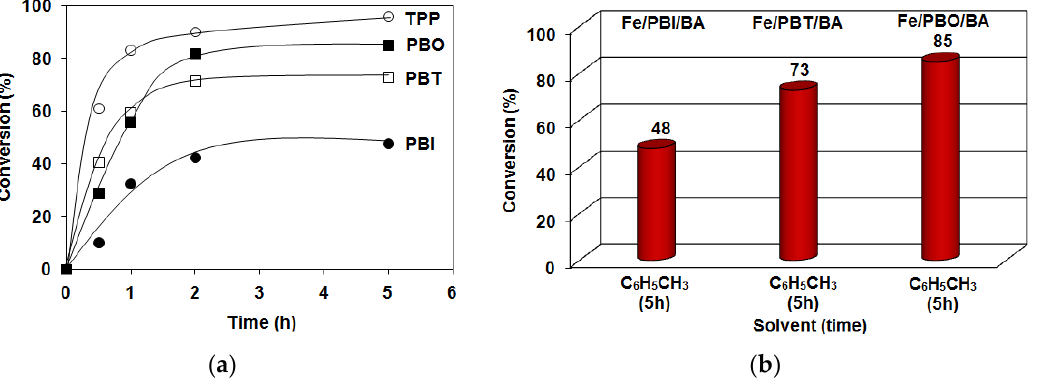
Figure 1. Comparison of the efficiency for the oxidation of cyclohexanone employing [Fe II (PBO) 2 (CF 3 SO 3 ) 2 ] ( 1 ), [Fe II (PBT) 2 (CF 3 SO 3 ) 2 ] ( 2 ), and [Fe II (PBI) 3 ](CF 3 SO 3 ) 2 ( 3 ) as catalysts: ( a ) time course of the oxidation of cyclohexanone; ( b ) comparison of the efficiency based on yields. Reaction conditions: [Fe] (0.01 mM), cyclohexanone (10 mM), benzaldehyde (150 mM), toluene (5 mL), O 2 bubbling, 60 °C, 5 h. Table 2. Dependence between the conversion and number of turnover values on the catalyst ( 2 ) and benzaldehyde concentrations for the iron(II)-catalyzed Baeyer–Villiger oxidation of cyclohexanone by molecular oxygen in the presence of benzaldehyde 1 .